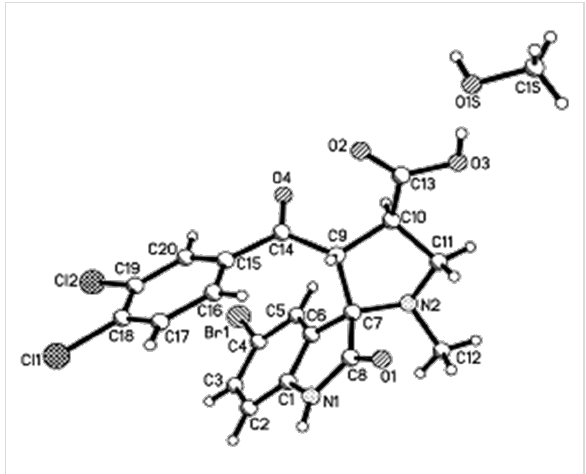
Figure 4: Molecular structure of spirooxindole 6a observed in crystal phase as solvate with methanol according to X-ray diffraction data.